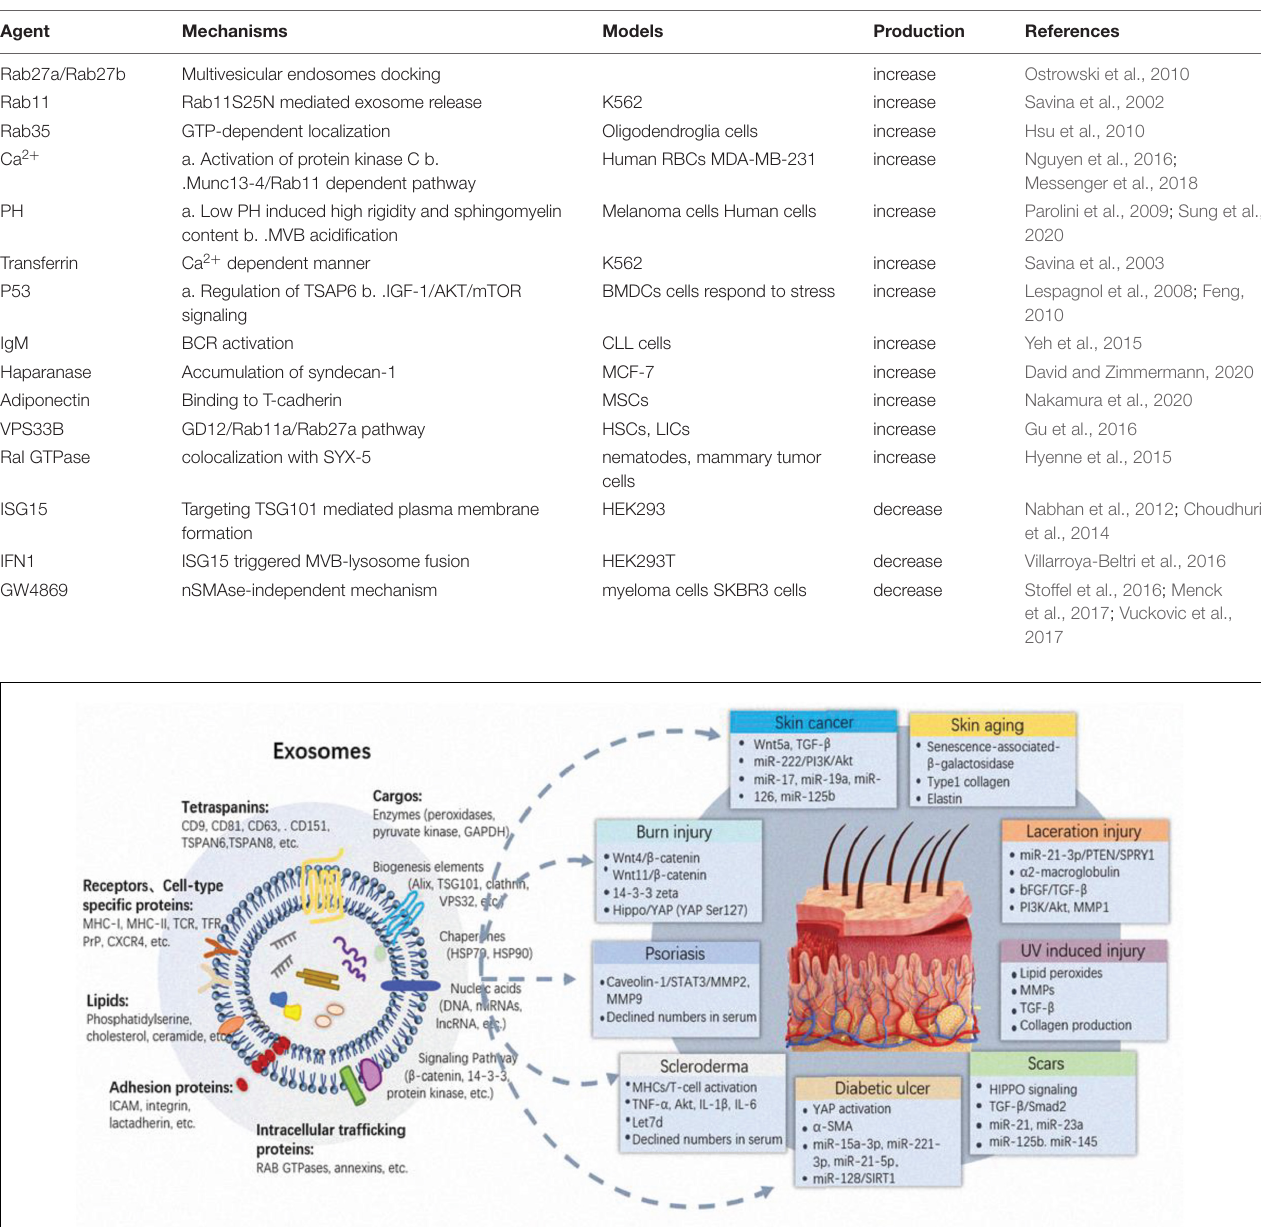
TABLE 1 | Approaches to affect exosome release.